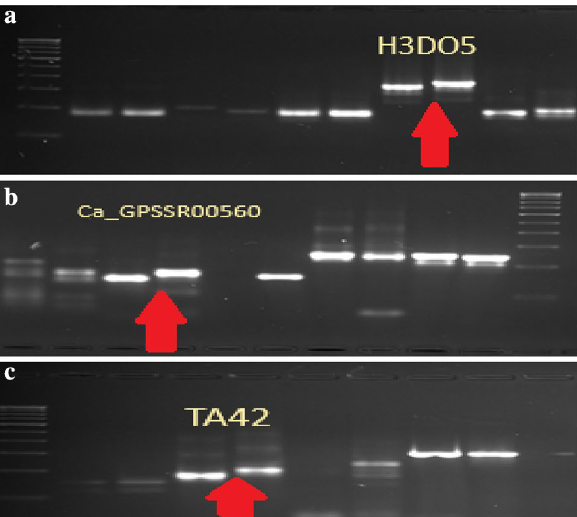
Figure 2. ( a ) Parental polymorphism of H3DO5 between BG362 (IDT) and BG3078-1(SDT). ( b ) Parental polymorphism of Ca_GPSSR00560 between BG362 (IDT) and BG3078-1(SDT). ( c ) Parental polymorphism of TA42 between BG362 (IDT) and